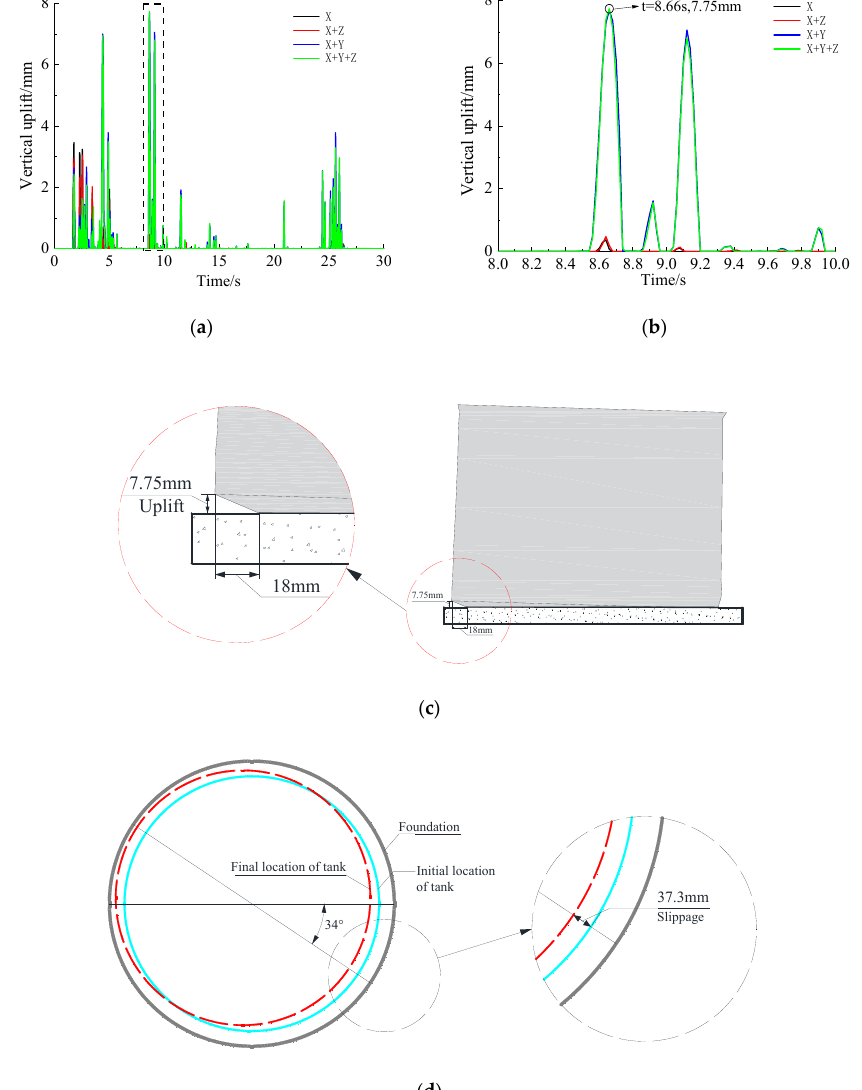
Figure 9. Uplift and slip behavior of the tank bottom under El Centro ground motion: ( a ) The whole time-history curve comparison of tank bottom uplift; ( b ) time-history curve of the uplift amount during t = 8.0 s to t = 10.0 s; ( c ) uplift behavior of the tank (t = 8.66 s, under the X + Y + Z excitation, after a certain amplification); ( d ) change of tank position before and after the earthquake (under the X + Y + Z excitation, top view).